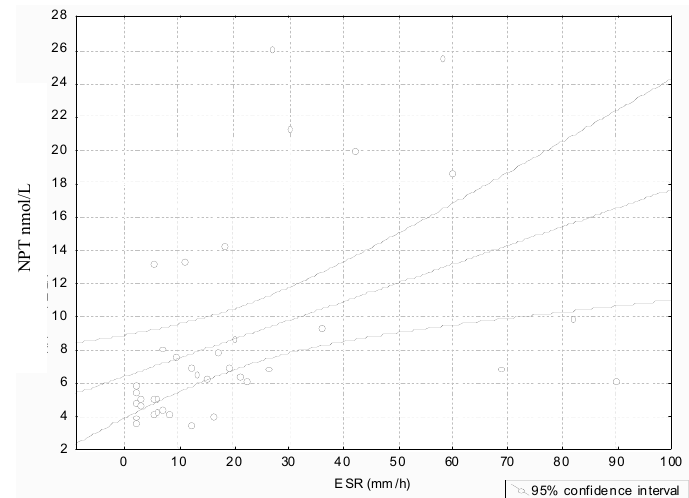
Figure 1. Correlation between serum neopterin concentration and erythrocyte sedimentation rate (ESR)